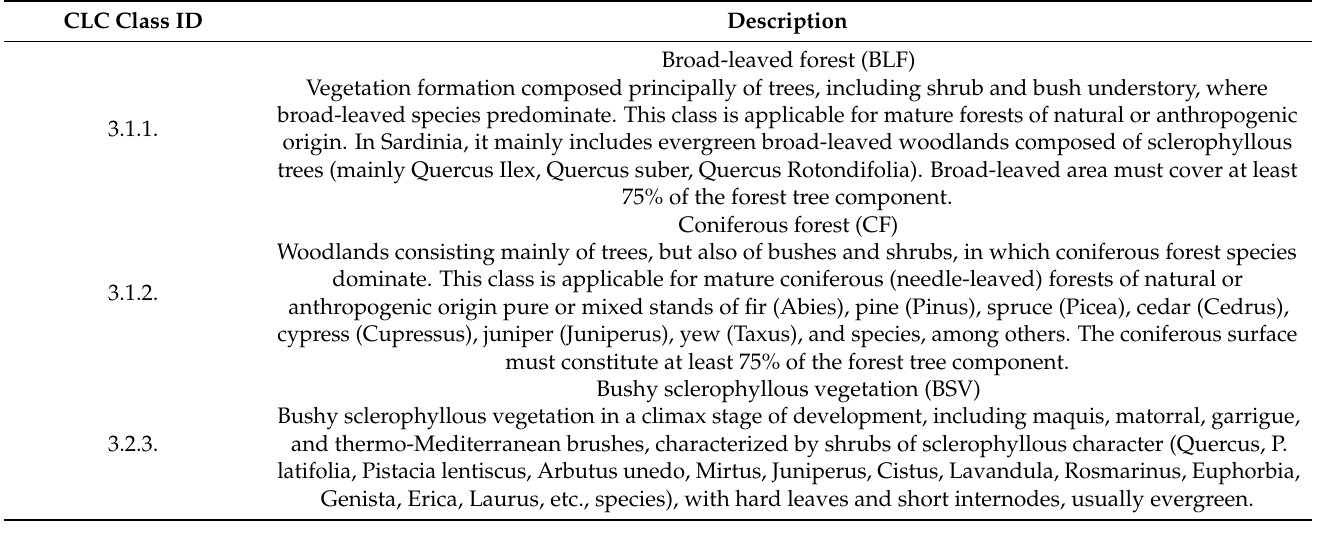
Table 1. Corine Land Cover classification and description of the land cover analyzed by this study.